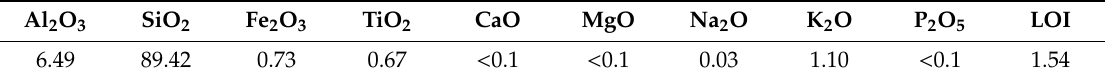
Table 5. Major components in the sample (%).